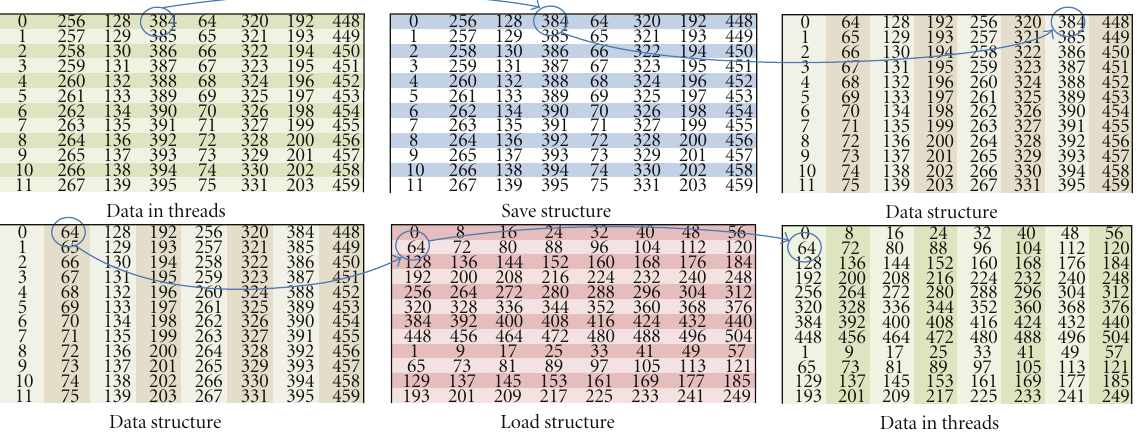
Figure 12: Sample of original load and save structures.